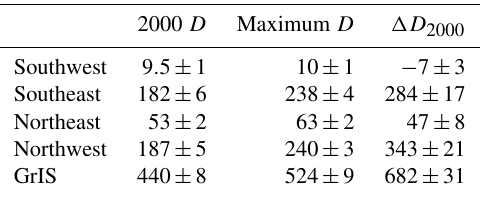
Table 2. Summary of D values for the total GrIS and four distinct regions (see Fig. 3), including the estimated mean annual D in 2000, the maximum D over the 2000–2016 period, and the cumulative D anomaly ( (cid:49)D 2000 ) relative to the 2000 estimate. All values are described in units of gigatonnes per year. A negative value indicates a reduction in D relative to the 2000 value. 2000 D Maximum D (cid:49)D 2000